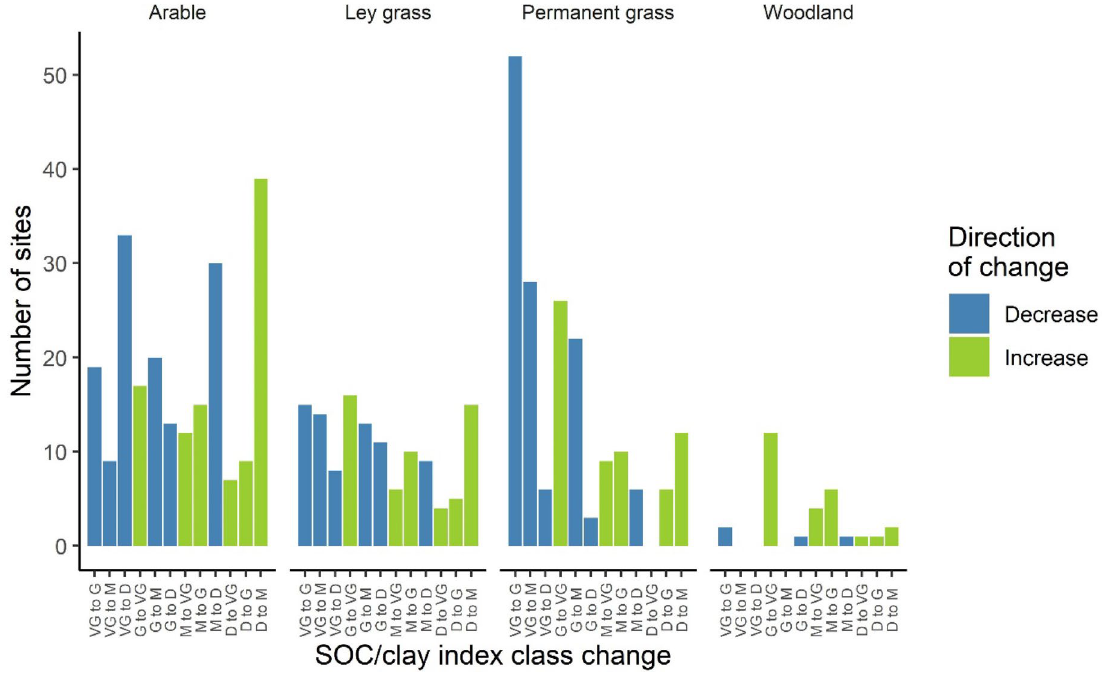
Figure 4. Numbers of sites that changed SOC/clay index class between the NSI samplings. Numbers of sites in each land use: arable, 223; ley grass, 126; permanent grass, 180; woodland, 30. VG, G, M and D indicate Very Good (SOC/clay ≥ 1/8), Good (SOC/clay 1/10–< 1/8), Moderate (SOC/clay 1/13–< 1/10), and Degraded (SOC/ clay < 1/13)